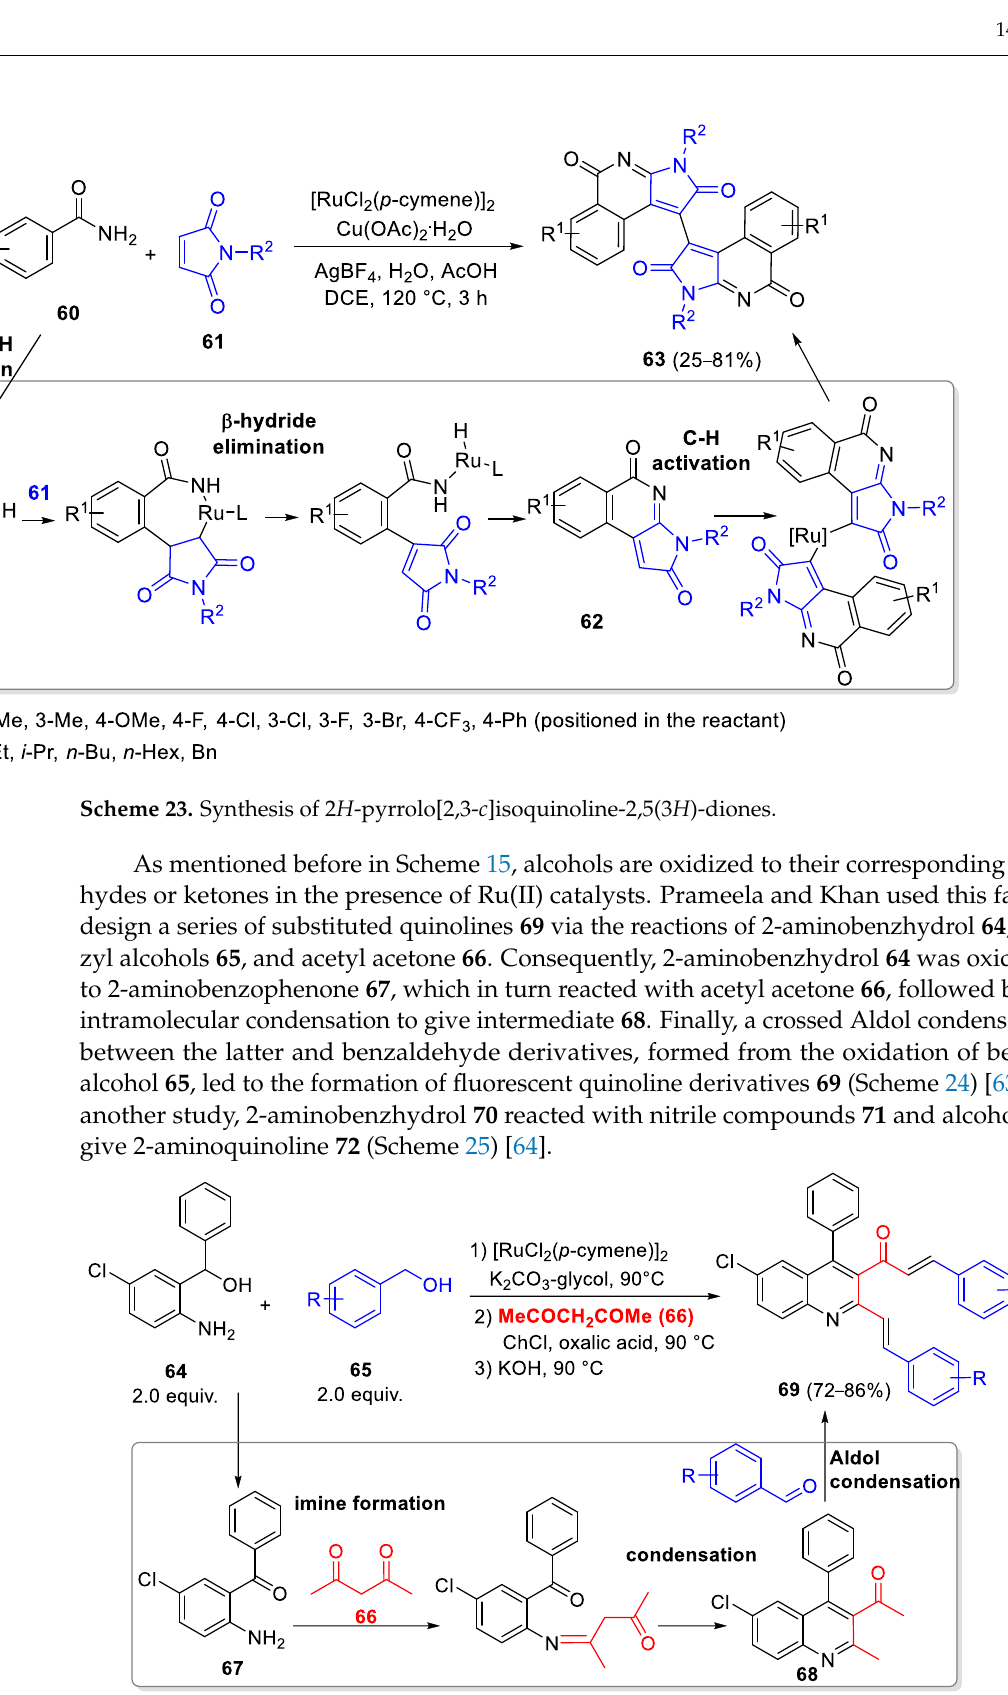
Scheme 24. Synthesis of quinoline